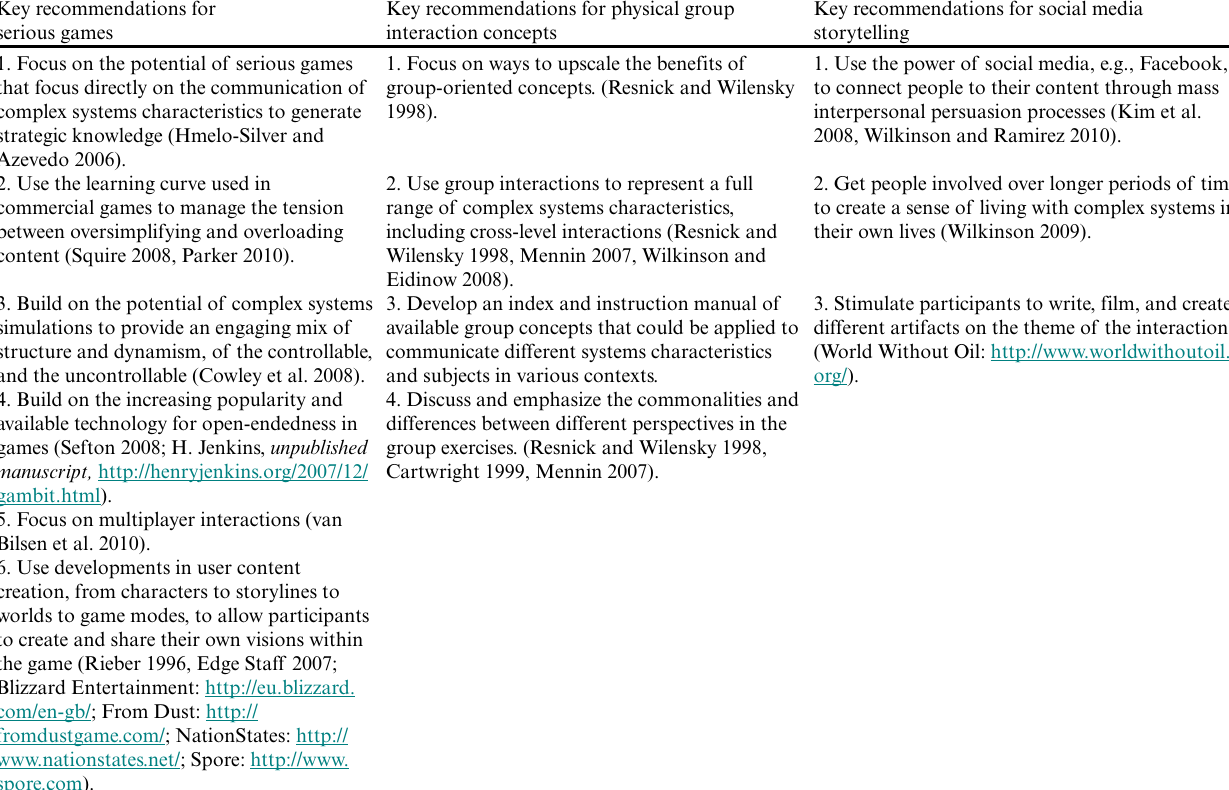
Table 3 . Recommendations for the development of serious games, physical group interaction concepts, and social media storytelling for the communication of social-ecological systems complexity, including